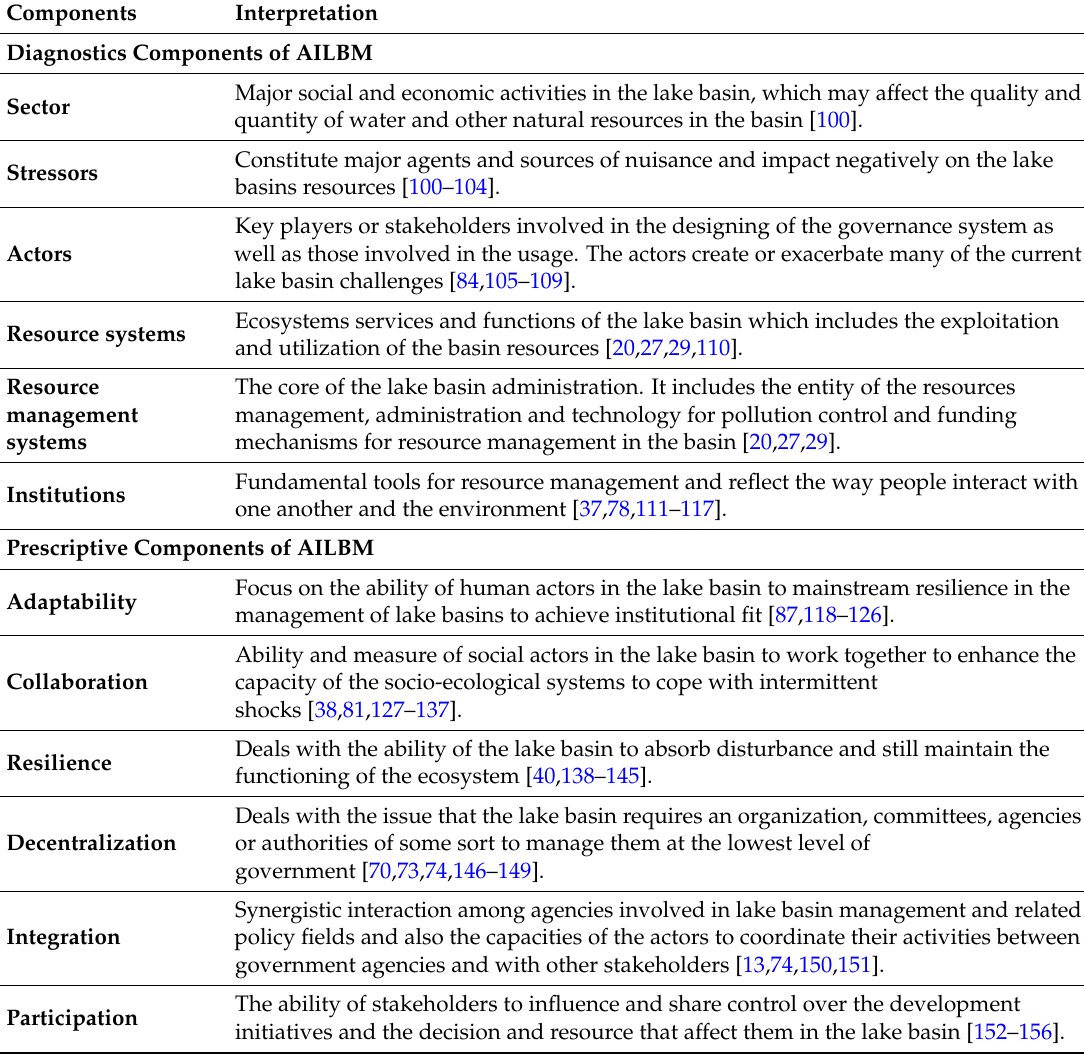
Table 1. Interpretation of the components of Adaptive Integrated Lake Basin Management